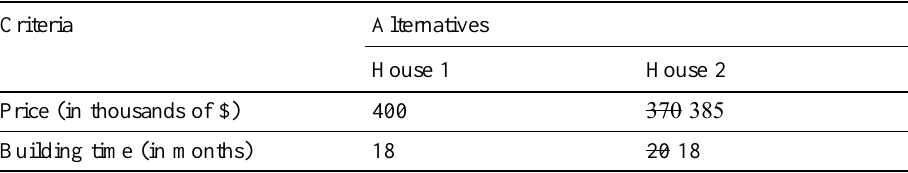
Table 2. Alternatives after even-swap